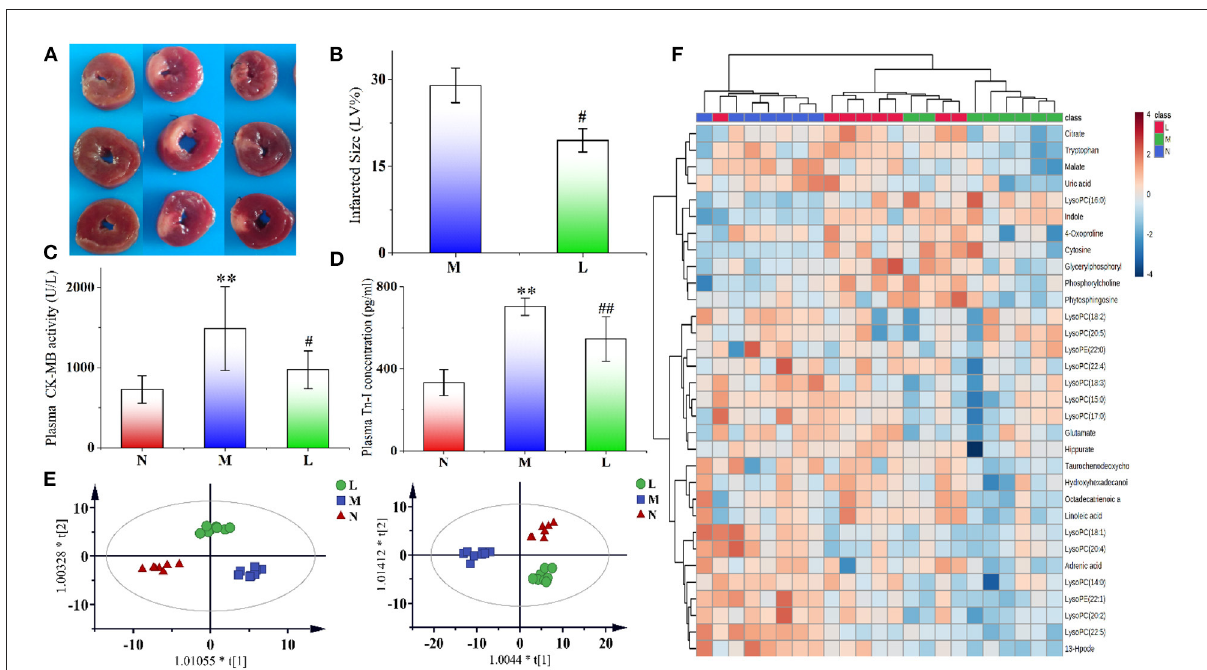
FIGURE2 (A) Typical cross sections of rat myocardium in the N, M, and L groups. We selected three typical myocardial tissue samples from each group for presentation. Areas stained red indicated normal myocardium, while areas not stained red and that were pale were infarcted. (B) Effect of leonurine on myocardial infarction size in rats with AMI. (C,D) Effects of leonurine on plasma CK-MB and Tn-I levels in AMI rats. (E) OPLS-DA score plots of the N, M, and L groups ( n = 8) from metabolomics in positive ( R 2 = 0.915, Q 2 = 0.772) and negative ( R 2 = 0.938, Q 2 = 0.755) modes. Red triangles, blue diamonds and green circles indicate the N, M, and L groups, respectively. (F) Hierarchical clustering heatmap showing the changes in potential biomarker content in the plasma of rats in the N, M, and L groups. The three groups achieved basic separation based on 32 potential biomarkers. The N and M groups were completely separated, and the L group approached N group. N, the sham-operated group; M, the acute myocardial ischemia model group; L, the leonurine administration group. ** p < 0.01 vs. the N group; # p < 0.05 and ## p < 0.01 vs. the M